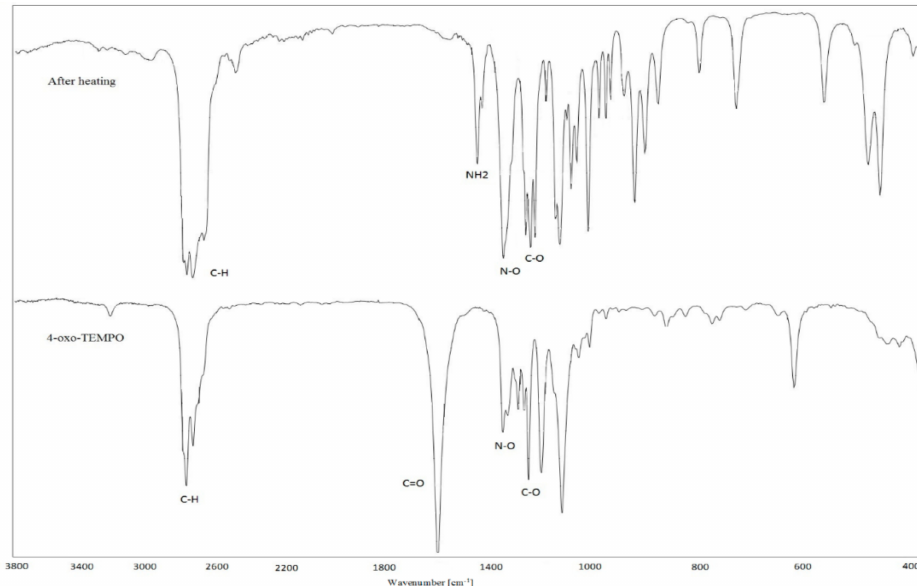
Figure 10. The FTIR spectrum of 4-oxo-TEMPO and decomposition products of 4-oxo-TEMPO.